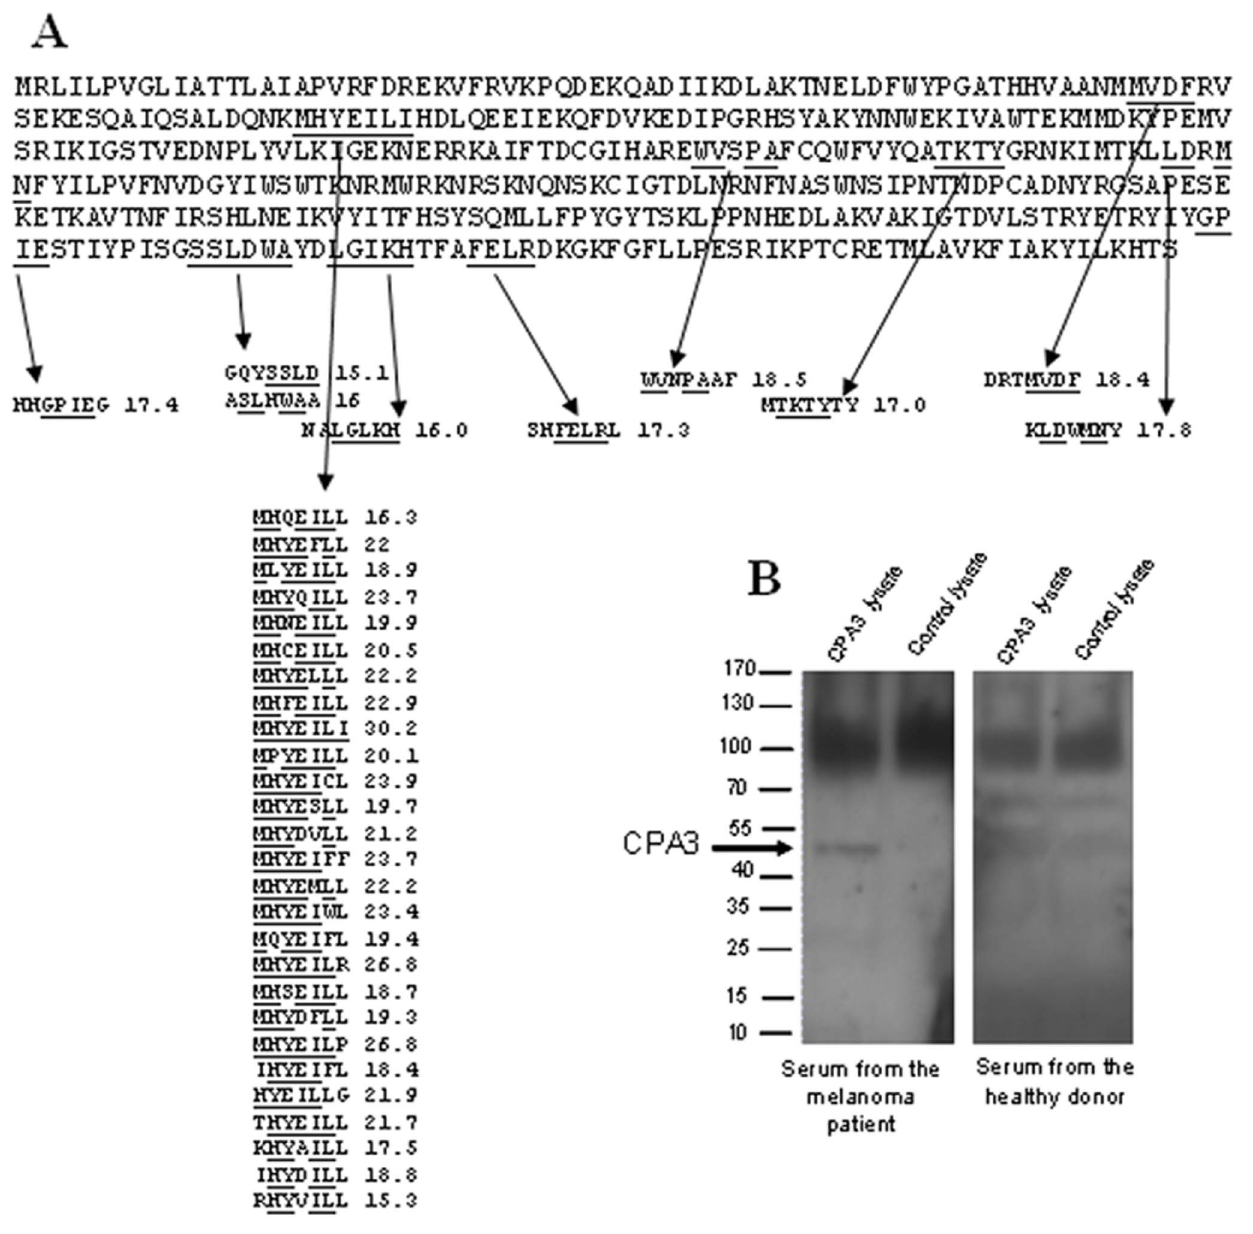
Figure 5. Epitope profile of the CPA3 protein generated by the serum from a melanoma patient . ( A ). The CPA3 amino acid sequence and the 36 matching peptides with the highest match scores generated by bl2seq program are shown. The sequences of the protein matching to peptides and the corresponding peptide sequences that match to protein are underlined. ( B ). Western blot analysis of the 293T cell lysates overexpressing the recombinant CPA3 protein or transfected with empty vector. The membranes were incubated with serum from either melanoma patient (left panel) or healthy donor (right panel). The reaction was developed as described in the ‘‘Materials and Methods’’ section.